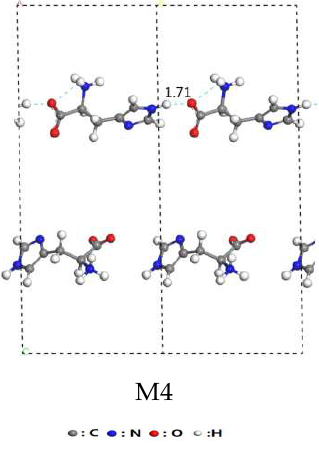
Figure 2. Structural model of histidine guest molecules (a 2b c).